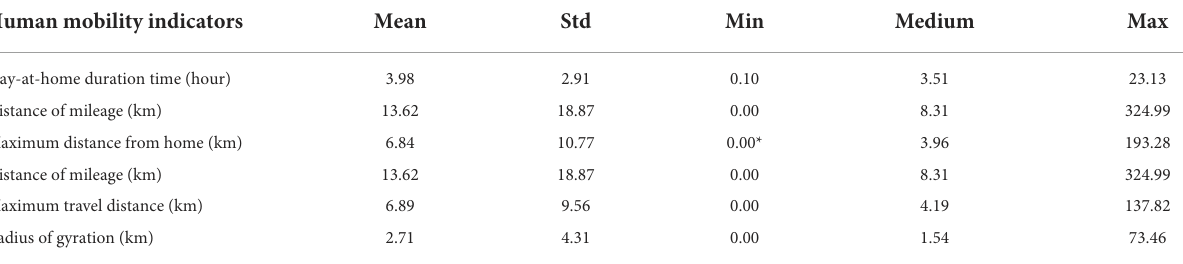
TABLE 4 Statistical descriptions of individual’s stay-at-home and travel indicators during the whole observation period. Human mobility